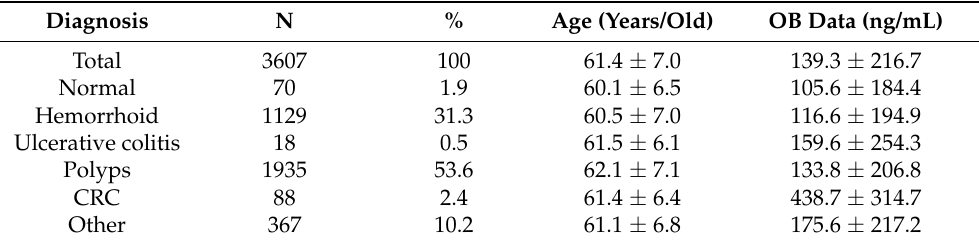
Table 4. Results of Further Diagnosis of Screening Positive